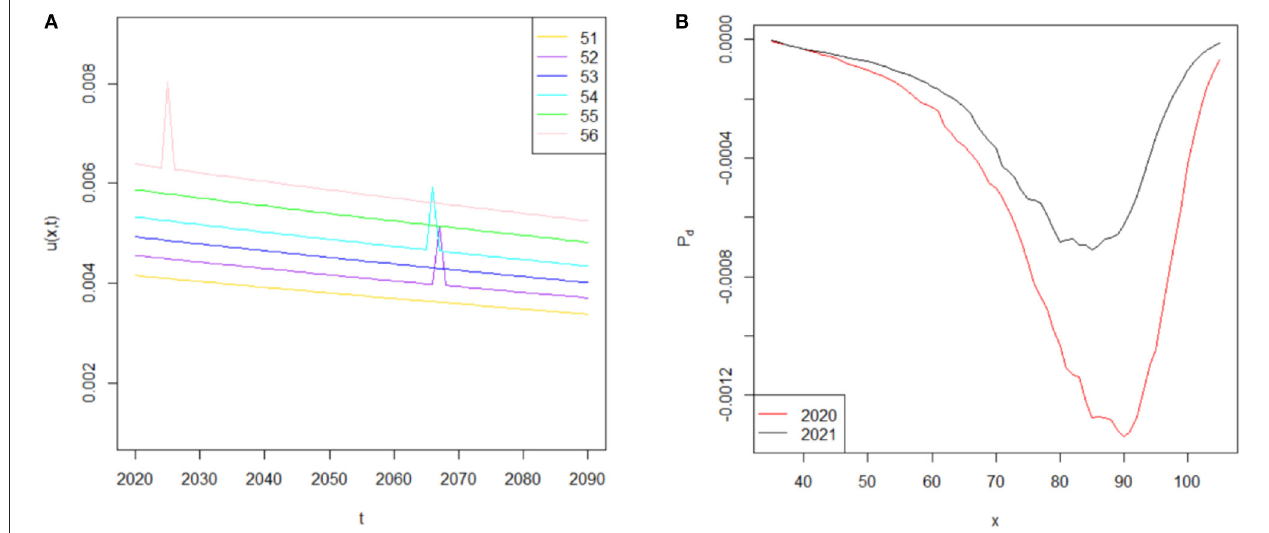
µ J ( 56, t ) . (B) The difference in conditional expected k-year survival rate for age 35 at time t during the µ J ( 51, t ) to ˜ ˜